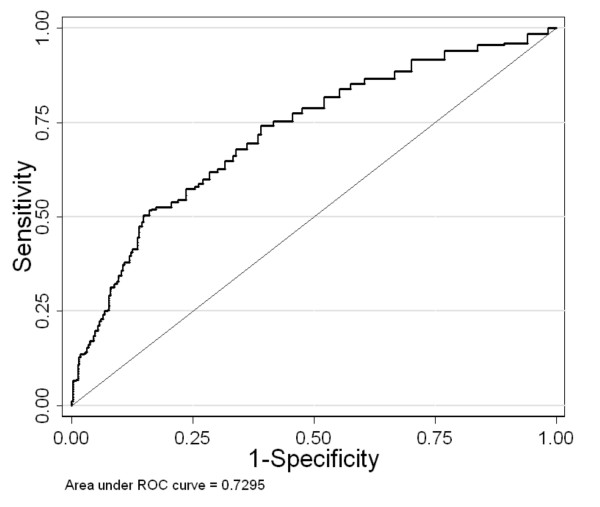
Receiver operating characteristic (ROC) curve for MPS-H test. Area under the curve is 0.73 (CI95: 0.69 – 0.76, p = 0.001)